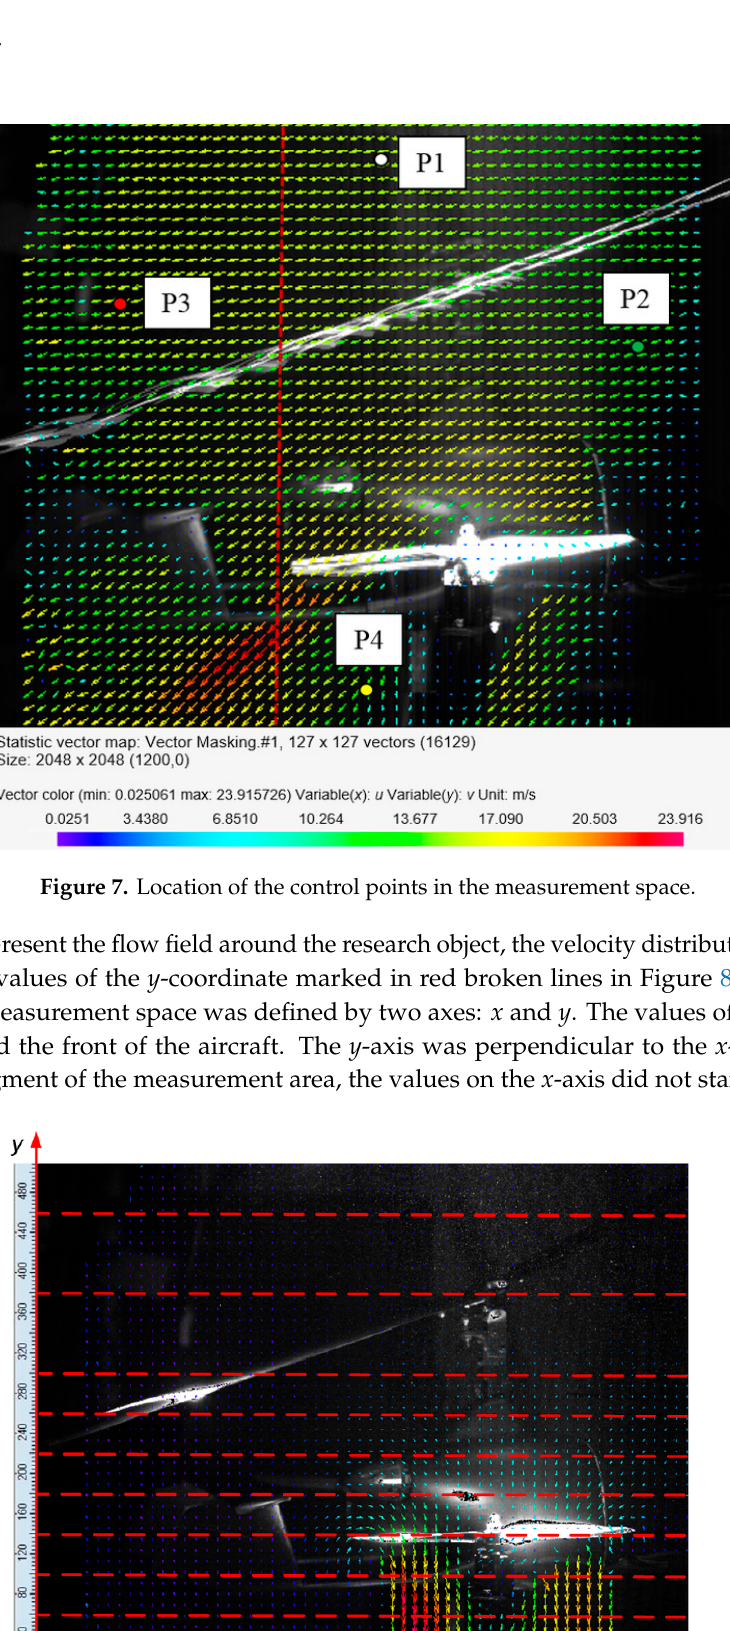
Figure 8. The adopted coordinate system of the examined area around the aircraft, along with the cross-sections considered (horizontal axis— x , vertical axis— y ).